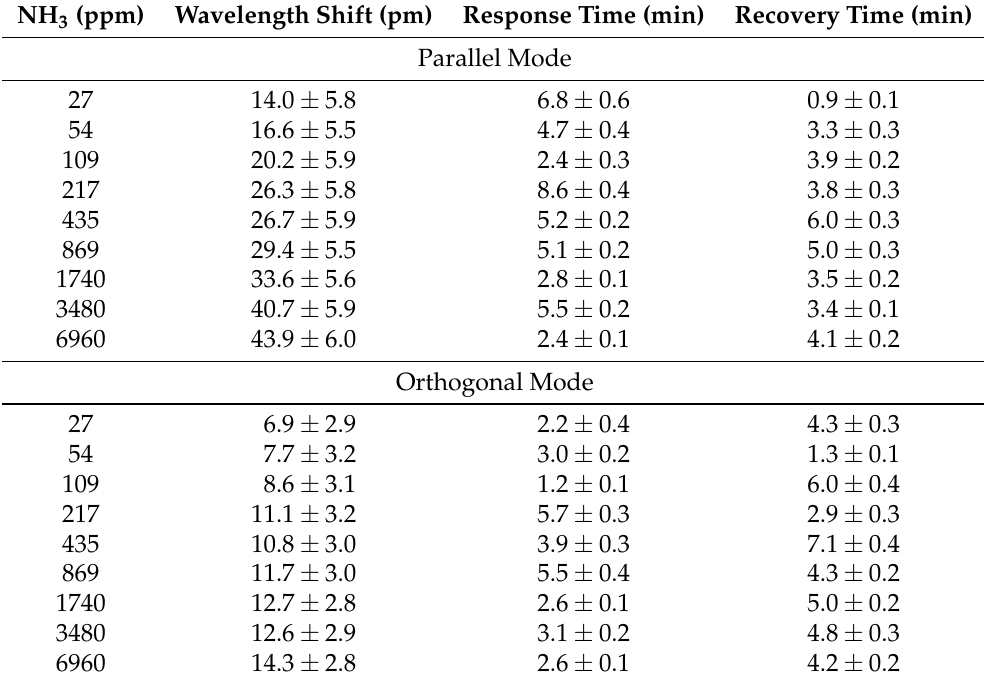
Table 1. Mean values of the fit results using Equation (2) for each [ NH 3 ] concentration regarding the parallel and the orthogonal